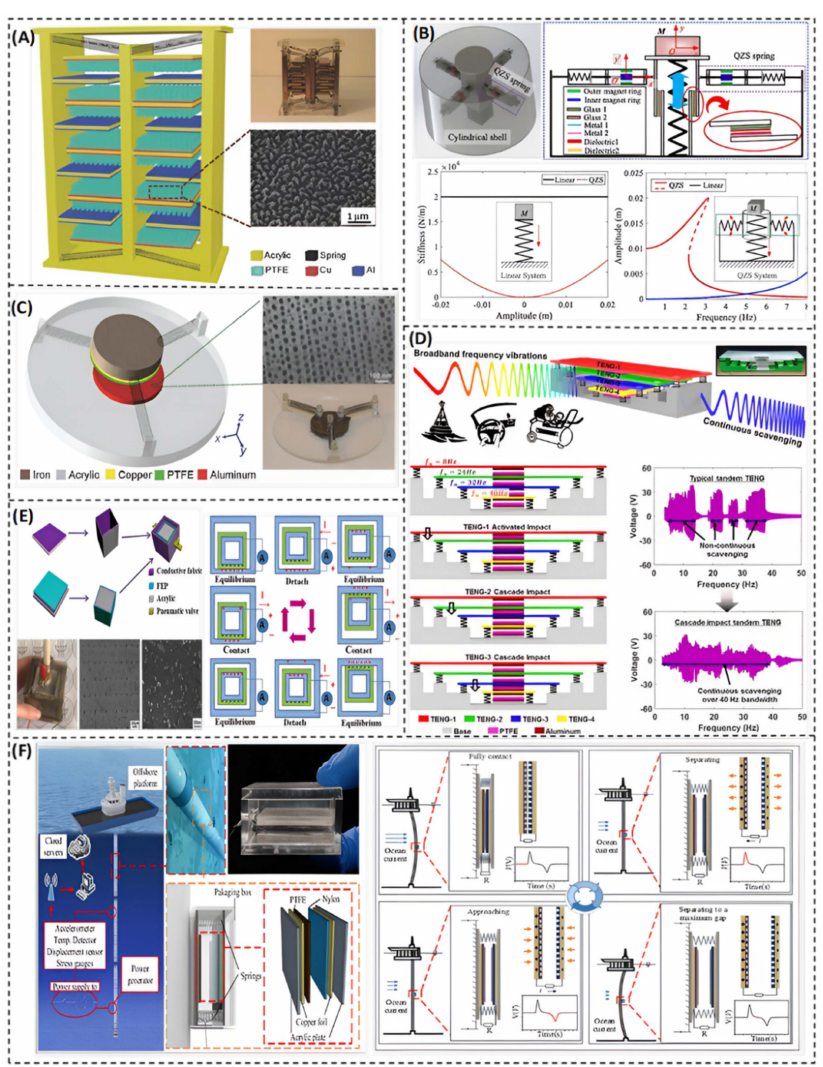
Figure 3. Vibration energy harvesting based on only TENG. ( A ) A 3D stack integrated triboelectric nanogenerator with a wide bandwidth of 36 Hz (Reprinted with permission [64], copyright 2014, John Wiley and Sons). ( B ) An energy harvester based on sliding mode triboelectric nanogenerator with a QZS system to gain an ultra-low stiffness in large displacement region (Reprinted with permission [65], copyright 2021, Elsevier). ( C ) A 3D TENG-based energy harvester that combines two operational TENG modes: vertical contact-separation mode and in-plane sliding mode (Reprinted with permission [66], copyright 2014, John Wiley and Sons). ( D ) A triboelectric nanogenerator with cascade structure based on impact to scavenge a wide range of input frequencies (Reprinted with permission [67], copyright 2019, Scientific Reports). ( E ) A gas-enhanced triboelectric nanogenerator based on fully enclosed structure that replaced the air with SF6 so that the output voltage and output current could be increased by 67% and 120%, respectively (Reprinted with permission [68], copyright 2018, Elsevier). ( F ) A contact-mode TENG to harvest vibrations of marine pipes (Reprinted with permission [69], copyright 2021,